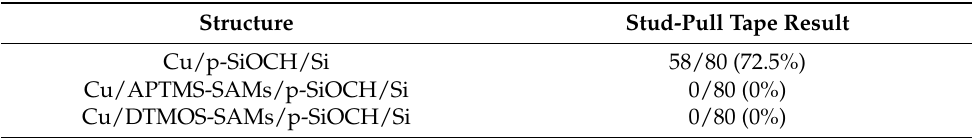
Table 3. Results of stud-pull tape tests for the pristine, APTMS-SAMs, and DTMOS-SAMs p-SiOCH